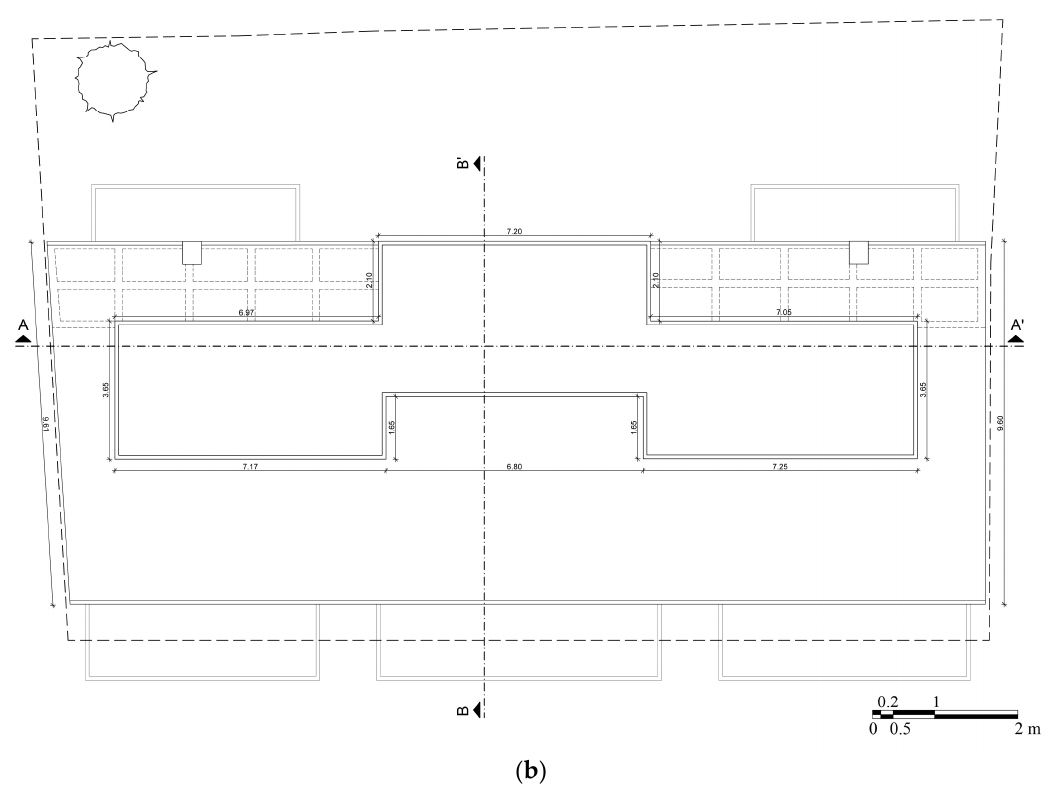
Figure A2. Reference building drawings of ( a ) the 4th floor plan and ( b ) the terrace floor plan.